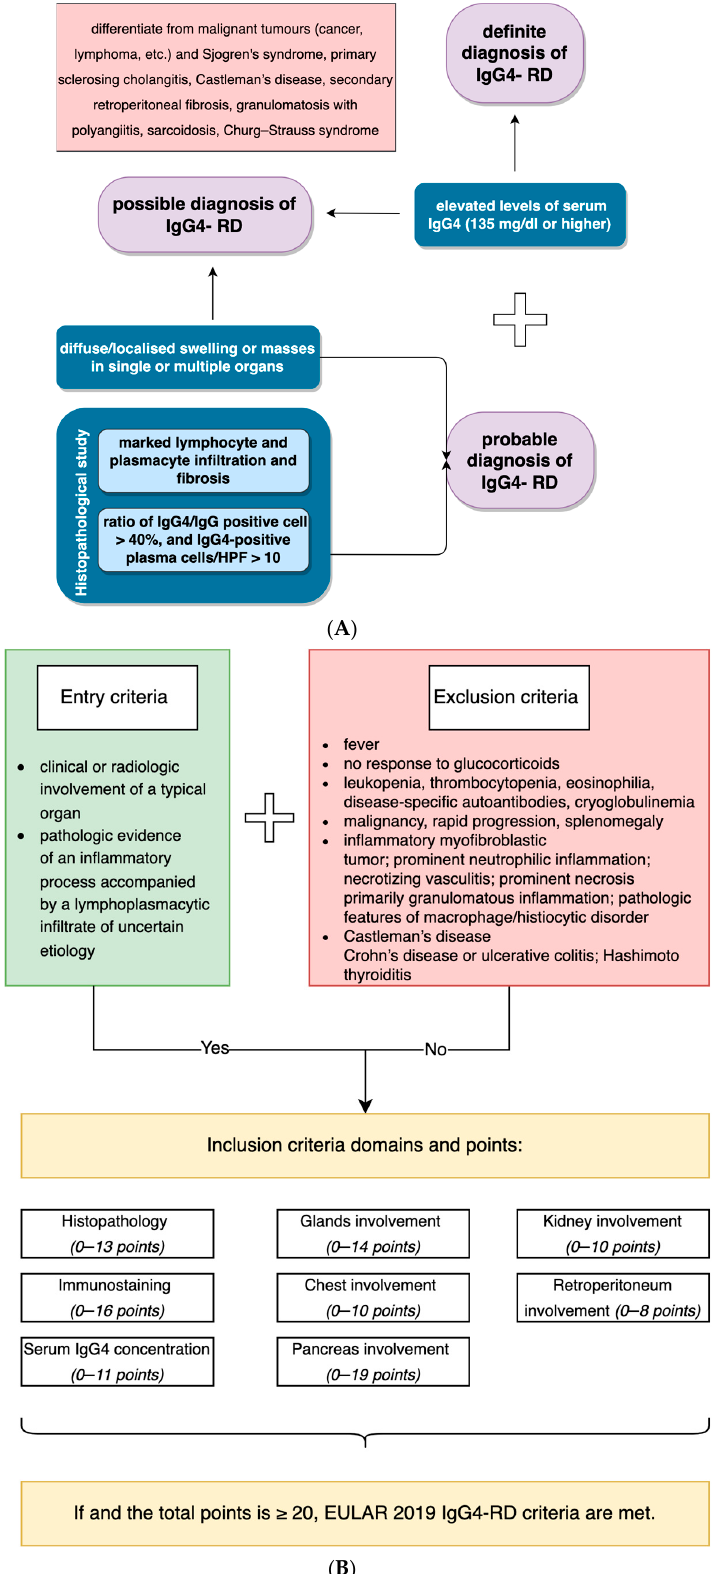
Figure 4. Comparison of the Comprehensive ( A ) and ACR/EULAR criteria for IgG4-related disease ( B ).